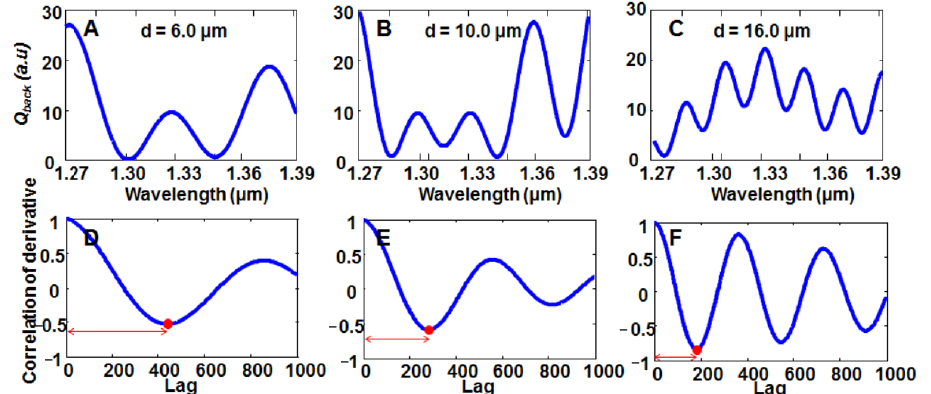
Figure 12. Backscattering Mie spectra for ( A ) 6 μm, ( B ) 10 μm and ( C ) 16 μm scatterers with medium and sphere refractive indices set at 1.47 and 1.59 respectively. The parameters for the calculations were chosen according to the specifications of the light source and the microsphere samples used in the experiments. Graphs ( D – F ) show the correlation of the derivative (COD) with the red dot indicating the first minimum and the red arrow indicating the bandwidth of the COD [181].